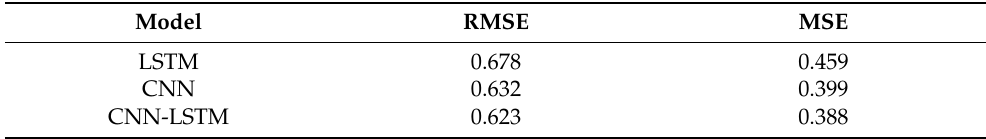
Table 2. Performance in test data sets for each model.